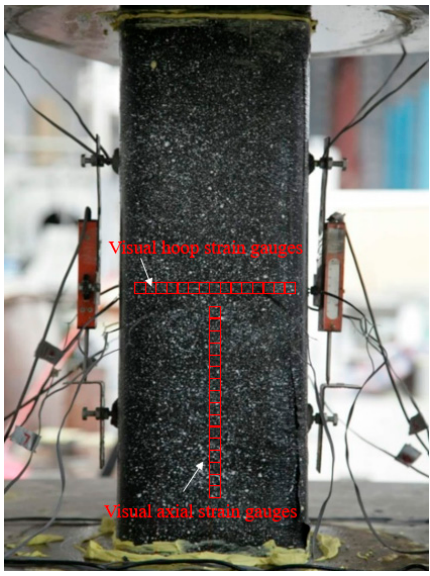
Figure 5. The visual strain gauges based on PIV image acquisition.